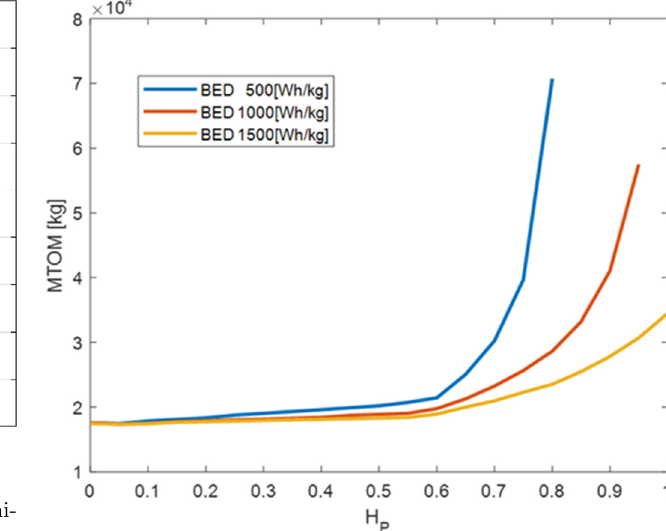
Fig. 11. Plot of the MTOM vs H P graph for a box-wing con fi guration at W/S=350kg/m 2 , varying the battery energy